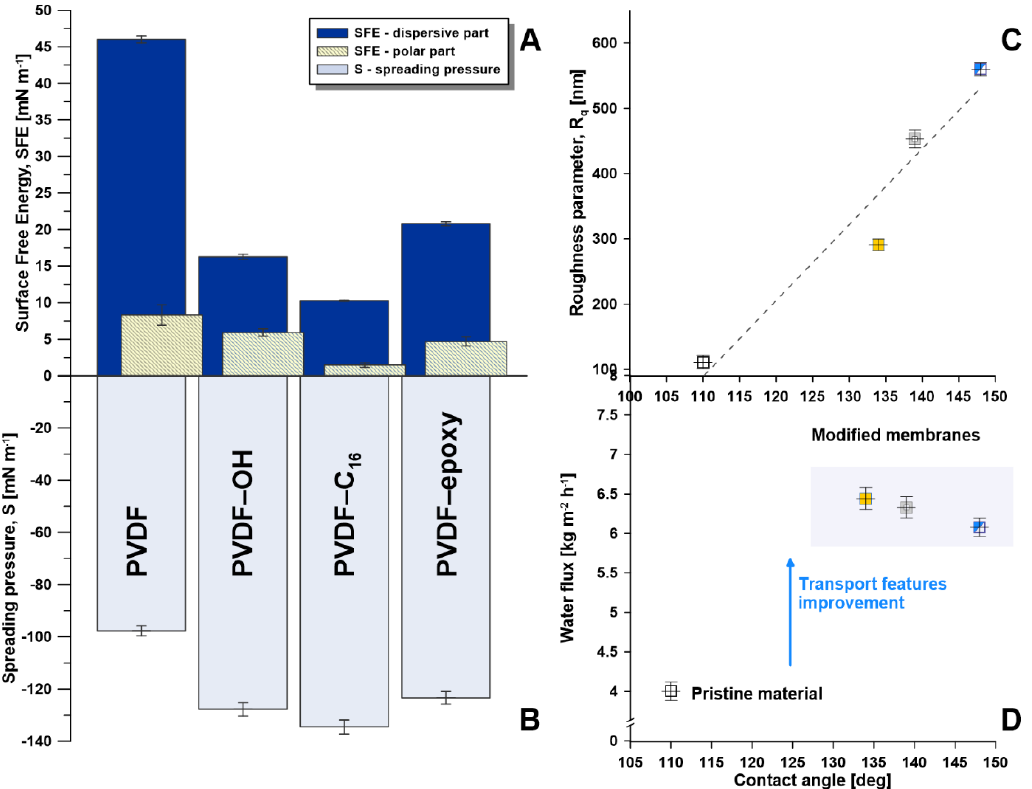
Figure 5. Wetting characterization, ( A )—SFE, ( B )—spreading pressure, ( C )—relation between roughness and water contact angle, ( D )—relation between water permeate flux and water contact angle.